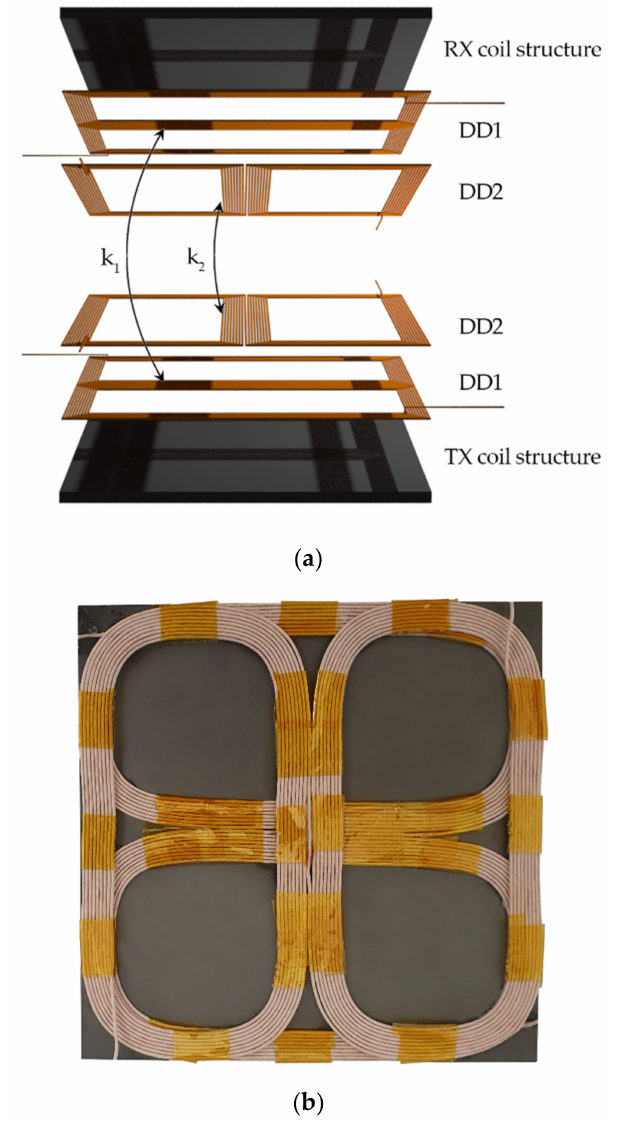
Figure 1. Double DD coil structure. ( a ) Double DD coil structure on the transmitter and the receiver side, ( b ) fabricated double DD